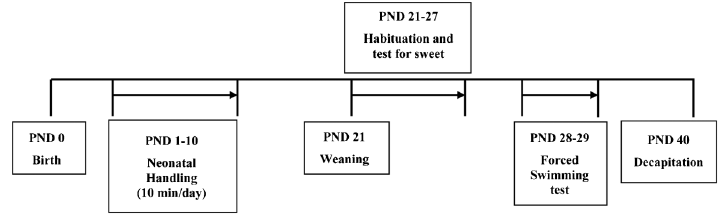
Figure 2. Scheme for the second set (forced swimming test) of beha- vioral tasks in separated and non- separated dams on postnatal days 28 to 29, for n = 9 dams/group.